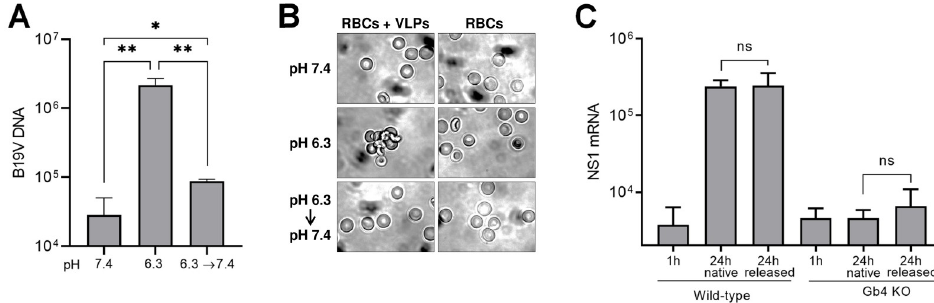
Fig 5. pH acts as an affinity switch to regulate binding and dissociation between B19V and Gb4. (A) B19V (510 9 ) was incubated with RBCs (0.5% in 100 μ l PiBS) for 1h at pH 7.4 or 6.3. The cell suspensions were washed twice with a buffer of the same pH, except for one sample incubated at pH 6.3 and washed at pH 7.4. RBCs were incubated 30 additional minutes in the washing buffer at room temperature, washed twice, and viral DNA was extracted and quantified by qPCR. The results are presented as the mean ± SD of three independent experiments. � , p < 0.05; �� , p < 0.01. (B) Visualization of the hemagglutination reaction by VLPs. RBCs were incubated with VLPs (510 9 ) at pH 7.4 or 6.3 for 1h at room temperature. Prior to visualization by phase contrast microscopy, the samples were diluted with a buffer of the same pH or neutralized to pH 7.4. (C) Infectivity of Gb4-dissociated virus. Viruses bound to RBCs at pH 6.3 and dissociated at pH 7.4 were quantified by qPCR. Equal amounts of native and Gb4-dissociated virus were added to UT7/Epo WT or Gb4 KO cells. After 1h or 24h, cells were washed four times and NS1 mRNA was extracted and quantified by RT-qPCR. The results are presented as the mean ± SD of three independent experiments. ns, not